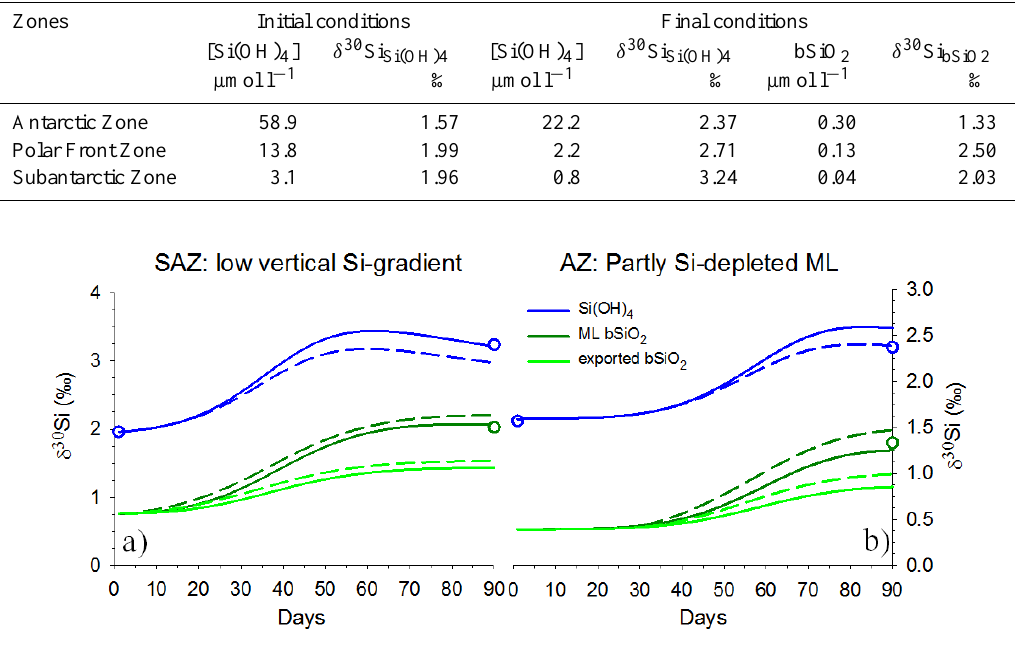
Fig. 8. Model outputs for the SAZ (a) and AZ (b) . Simulated δ 30 Si values for Si(OH) 4 , ML bSiO 2 , exported bSiO 2 without (full lines) and with (dashed lines) bSiO 2 dissolution isotopic fractionation ( 30 ε = − 0 . 55‰). The initial and final estimations are indicated by empty dots with the corresponding colors (Table 2). Respectively, for the SAZ and AZ: V max = 0 . 40 and 0.31 d − 1 , K Si = 2 and 10µmoll − 1 , k export = 0 . 11 and 0.13 d − 1 , Si(OH) 4 supply = 77 and 1170 mmol m − 2 , and net bSiO 2 production = 275 and 4149 mmol m − 2